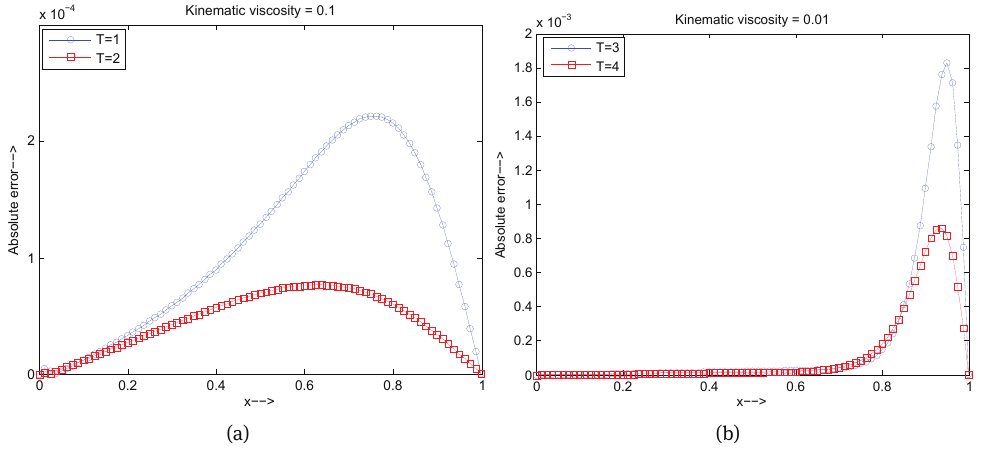
Fig. 16: Physical behavior of numerical solutions for Example 2 in 2D and contour form for ν = 0.00001 at different times with Δx = 0.0125 and Δt = 0.001 .